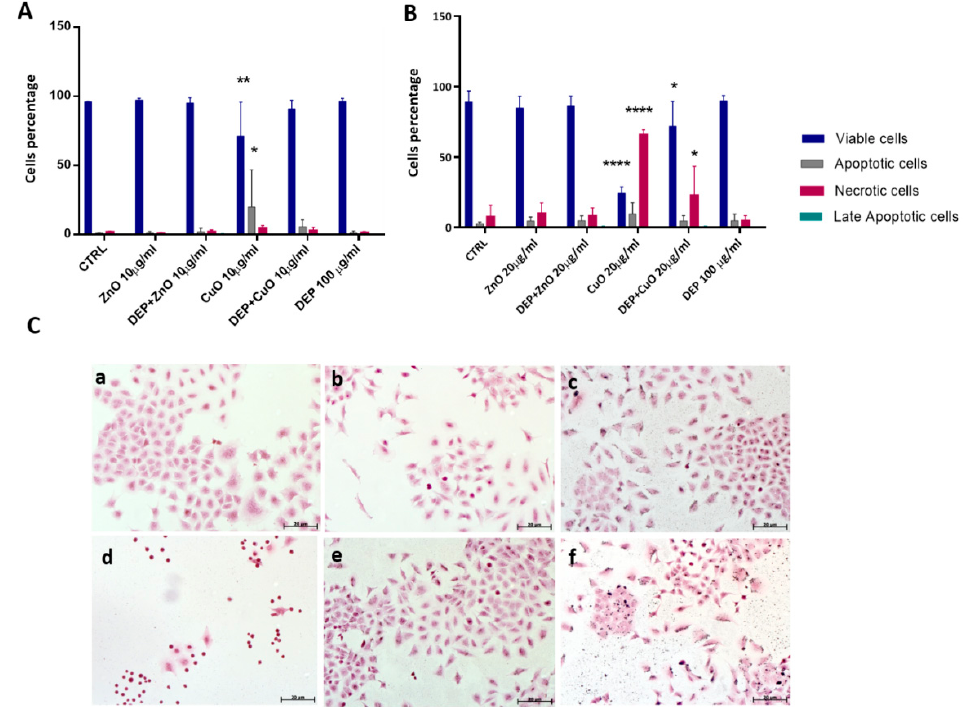
Figure 1. Cell death after exposure to particles. Panels A and B show flow cytometry analyses of cells stained with annexin V and PI after exposure to ZnO and CuO NPs at ( A ) 10 µ g/mL and ( B ) 20 µ g/mL, either alone or in mixture with DEPs (100 µ g/mL). Statistically significant with respect to the control according to one-way ANOVA, ** p < 0.01, * p < 0.05, and **** p < 0.0001 vs. control. ( C ) Morphological analysis. Microscope images of A549 cells, stained with hematoxylin/eosin: ( a ) control; ( b ) ZnO (20 µ g/mL); ( c ) DEP + ZnO (20 µ g/mL); ( d ) CuO (20 µ g/mL); ( e ) DEP + CuO (20 µ g/mL); ( f ) DEPs (100 µ g/mL); scale bar = 20 µ m.